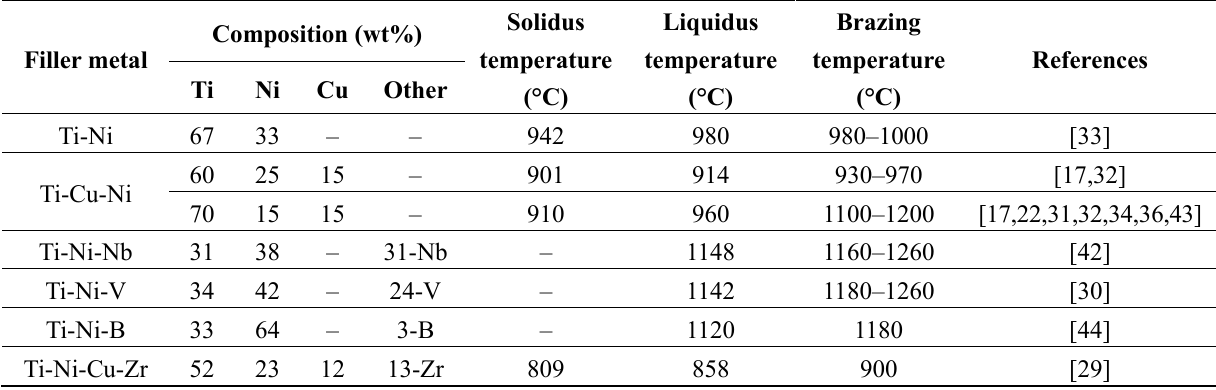
Table 1. A summary of the composition of Ti-based filler metal for brazing titanium aluminides. Filler